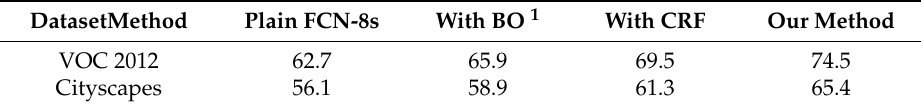
Table 1. The mIoU scores of the comparative experiments.